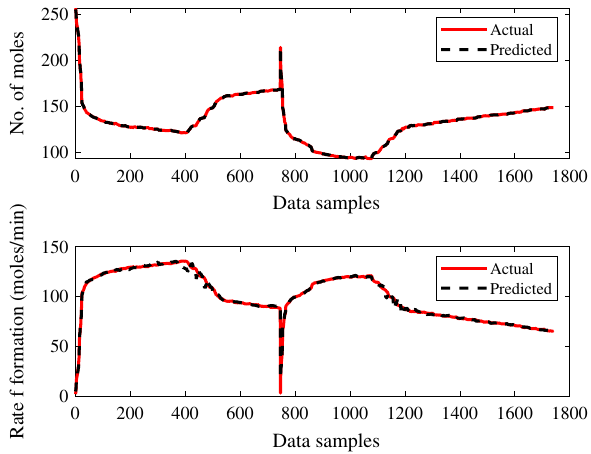
Figure 13. ANN testing performance for gas + CO 2 .